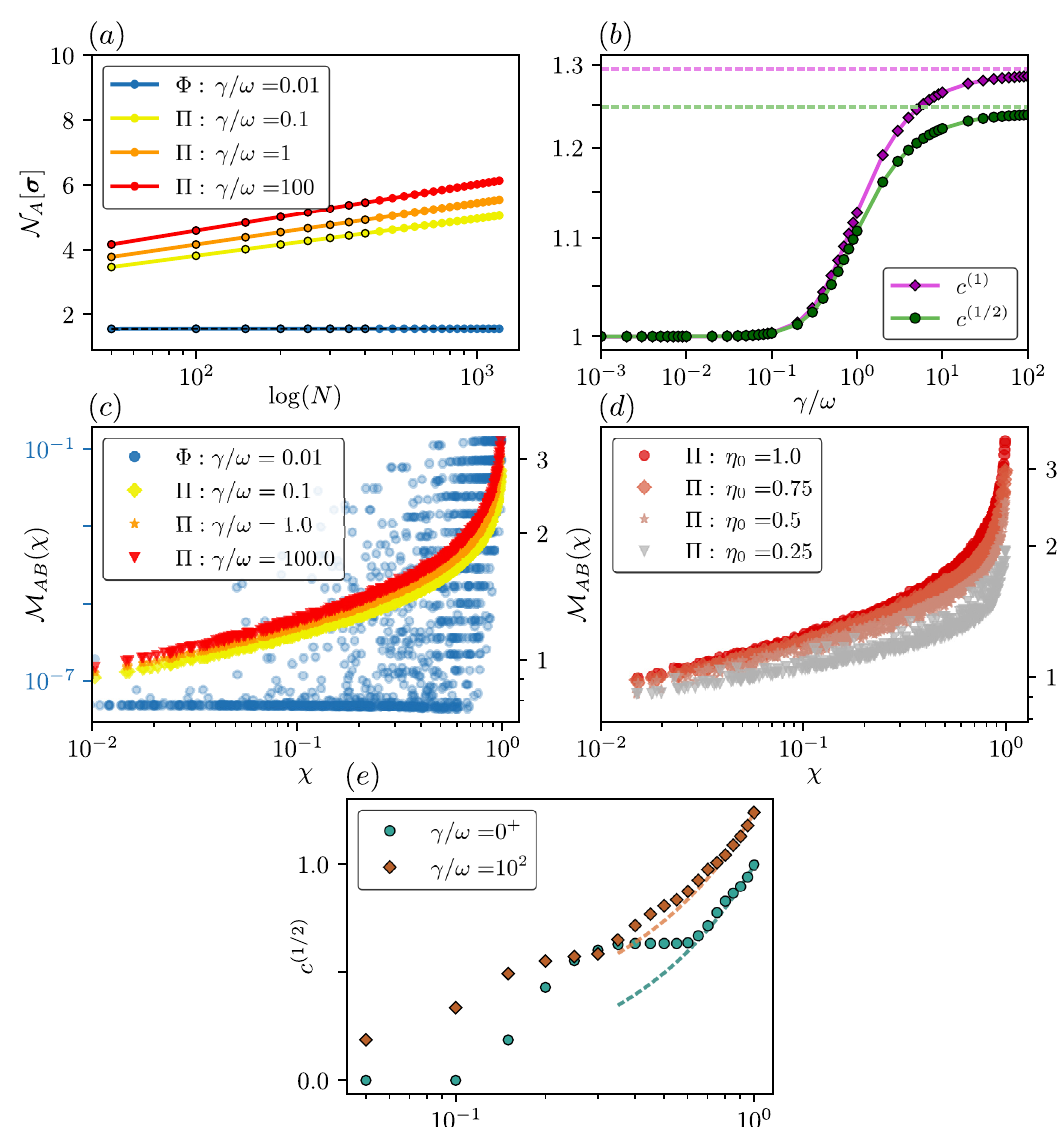
Figure 4: (a) Finite size scaling of the half system logaritmic negativity in the steady state for Π ( Φ ) measurements. The steady states have been obtained analytically for different system sizes N . For the Π ( Φ )-measurements we obtain a critical (area law) scaling. The markers with dark edges correspond to the steady state obtained from the numerical solution of Eq. (23). The black dashed line (on top of the blue) corresponds to the analytical result in Eq. (49). (b) Measurement enriched critical- ity from sliding logarithmic prefactors c ( α ) with respect to the measurement strength γ γ . The purple (green) line corresponds to the prefactor c ( 1 ) ( c ( 1 / 2 ) ) in the finite size scaling of the 1-Rényi entropy ( 1 -Rényi entropy / logarithmic negativity). The 2 dashed green (purple) line corresponds to the maximum attainable scaling constant ≈ 1.25 ( c ( 1 ) ≈ 1.29). (c) Data collapse (non-collapse) of the mutual neg- c ( 1 / 2 ) max max ativity for Π ( Φ )-measurements for different γ . (d) Collapse of mutual negativity for imperfect Φ -measurements at γ/ω = 100 and different measurement efficiencies η . (e) Dependence of the scaling prefactor c ( 1 / 2 ) in the logarithmic negativity on 0 the measurement efficiency η for a fixed measurement strength γ . The dashed line 0 corresponds to the linear decay of c ( 1 / 2 ) with η 0